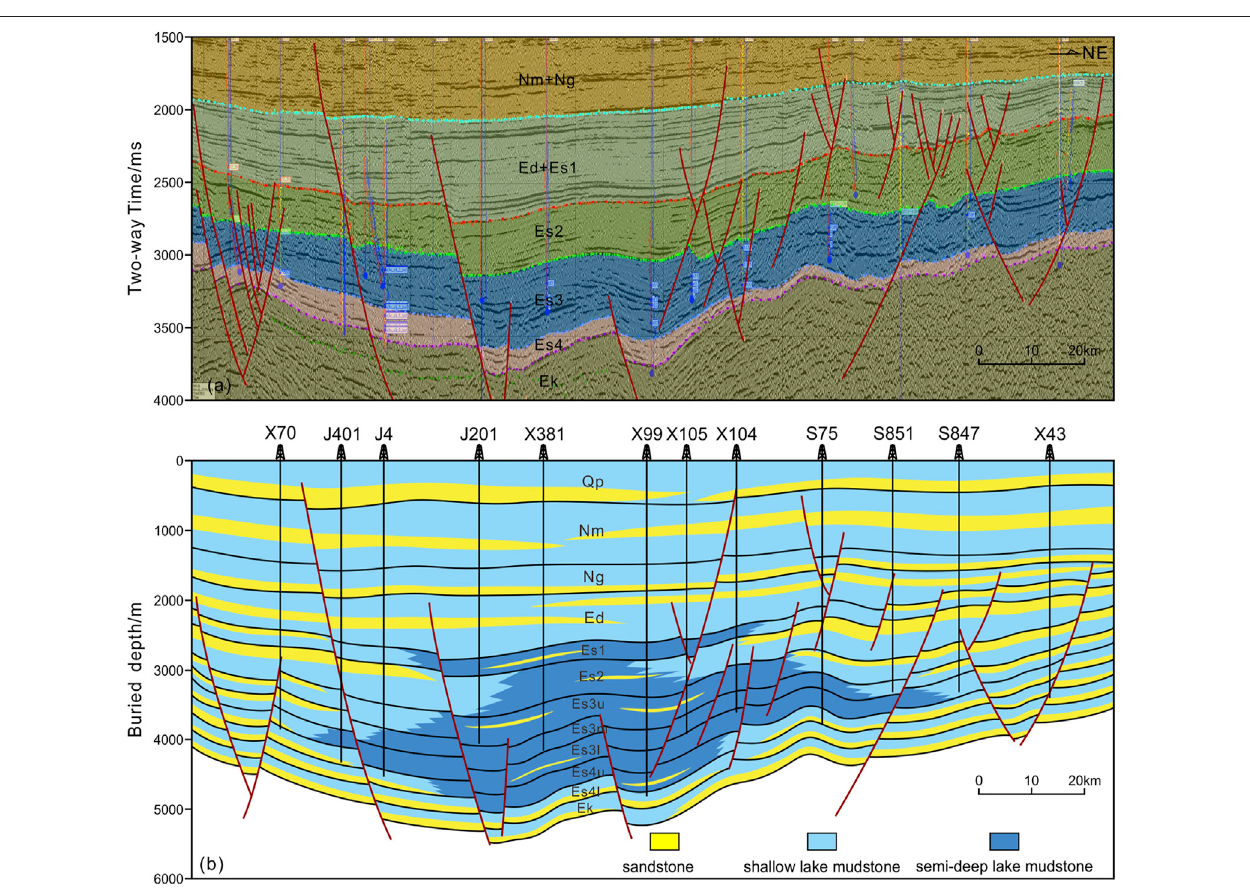
FIGURE 3 | Interpreted seismic section showing the structural framework of the study area. (A) The seismic section through the study area. (B) The structural and lithology interpretation of the cross section. It is assumed that wellhead fl uctuations are neglected considering the elevation is less than 20 m in the Linnan Sag. The location of the section is shown in Figure 1